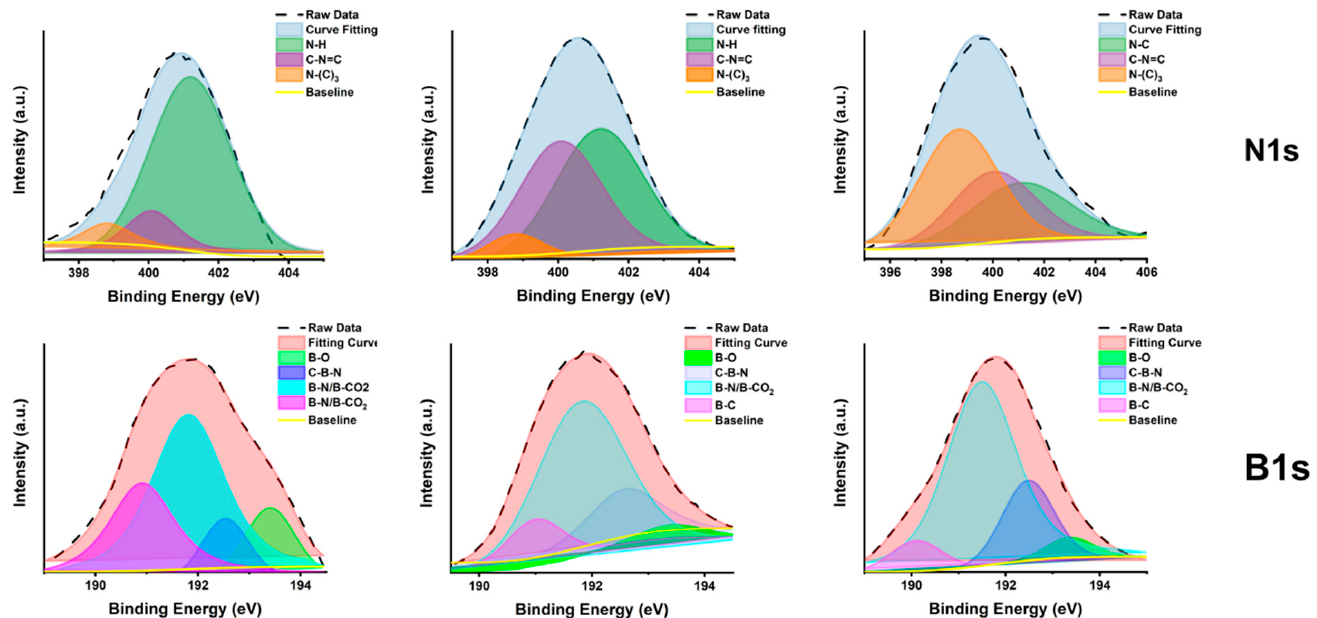
Figure 3. High-resolution XPS spectra of high-resolution C1s, O1s, N1s, and B1s at different pH conditions.